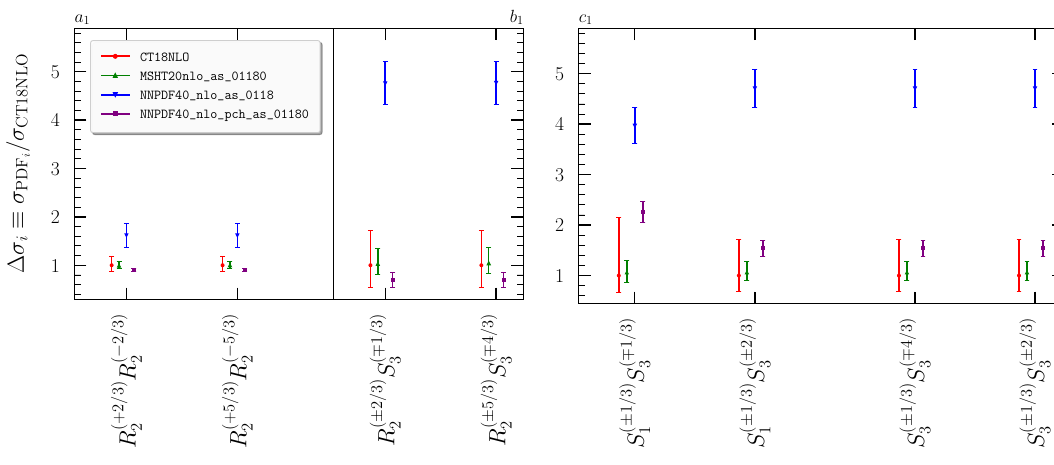
Figure 8 . Total cross section predictions, with the associated PDF uncertainties, for a selection of processes in scenario a 1 (left panel of left figure; see also table 4), b 1 (right panel of left figure; see also table 5), and c 1 (right figure; see also table 6). Predictions are normalised to the cross section obtained with the central CT18NLO PDF